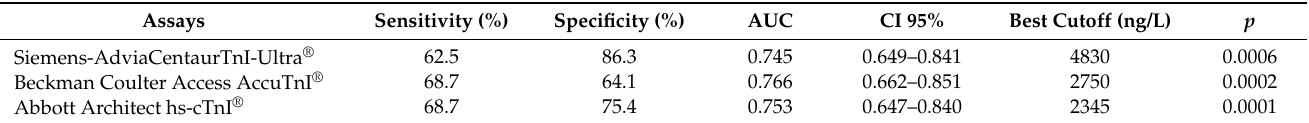
Table 5. ROC Curves of cTnI assays in